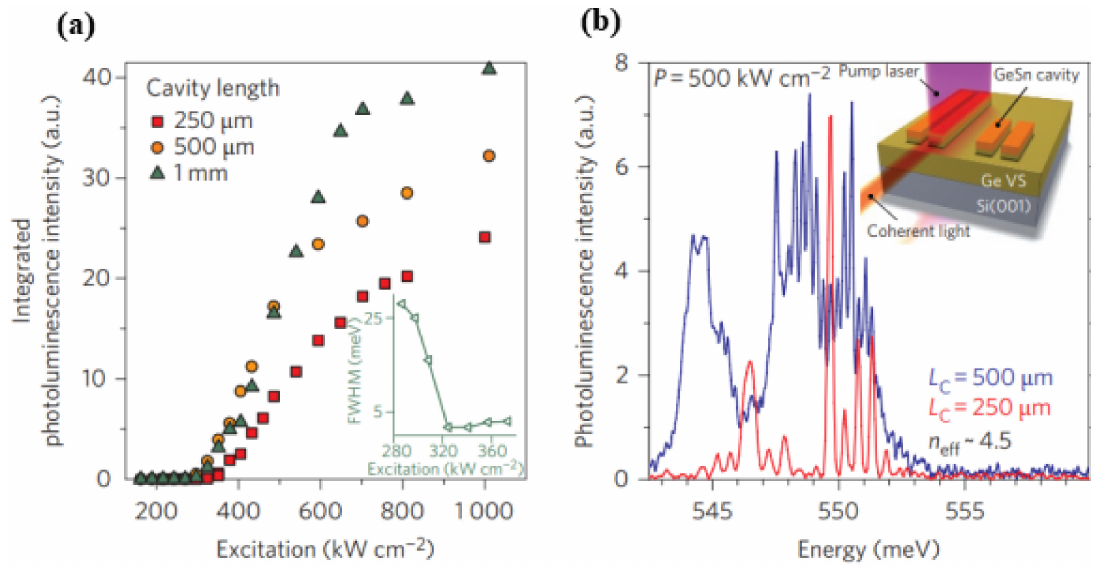
Figure 24. ( a ) Integrated PL intensity vs. excitation power density for a GeSn FP cavity laser with different cavity lengths; ( b ) high-resolution laser spectra for a GeSn laser with cavity lengths of 250 and 500 µ m. Reproduced with permission from [70], Springer Nature,